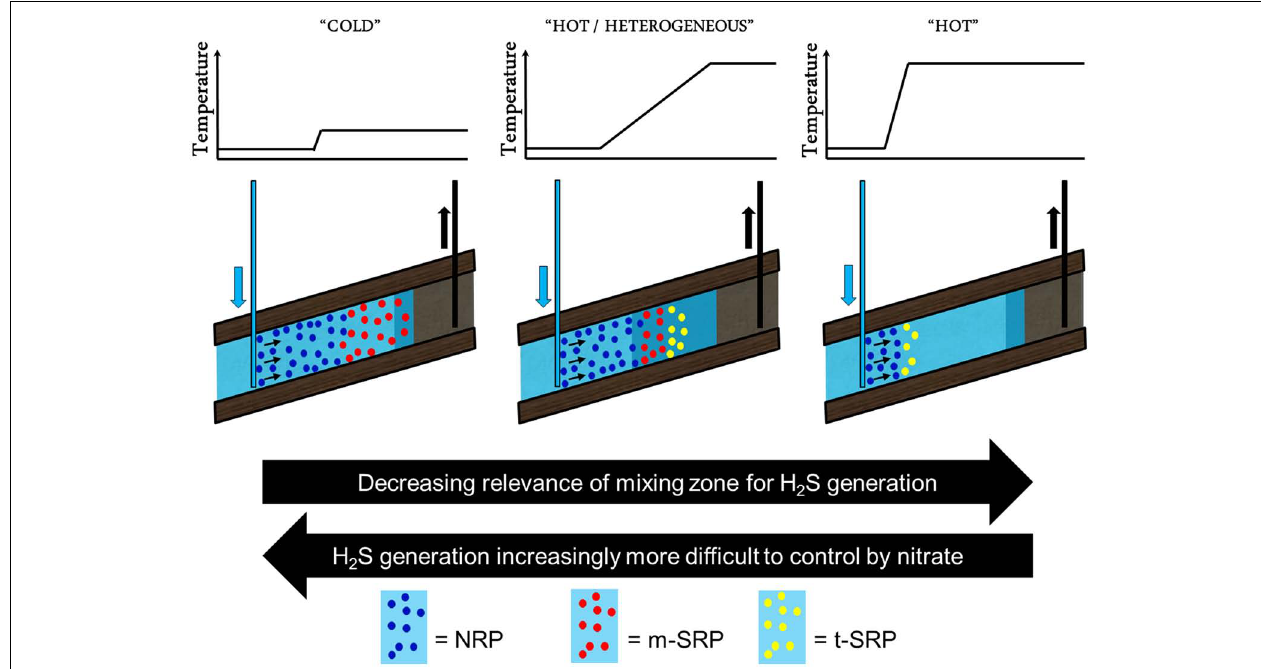
FIGURE 3 | Schematic representation of water flood with nitrate injection in cold, and hot oil reservoirs with heterogeneous and homogeneous permeability distribution. The difference in the thermal gradient (graph) and the size of the injection/formation water mixing zone (dark blue) determine zones that are dominated by nitrate- (NRP, blue), mesophilic and (hyper)thermophilic SRP (m-SRP, red and t-SRP, yellow, respectively). Hyperthermophilic nitrate-reducing microorganism like e.g., Pyrobaculum aerophilum have not yet been identified in significant numbers